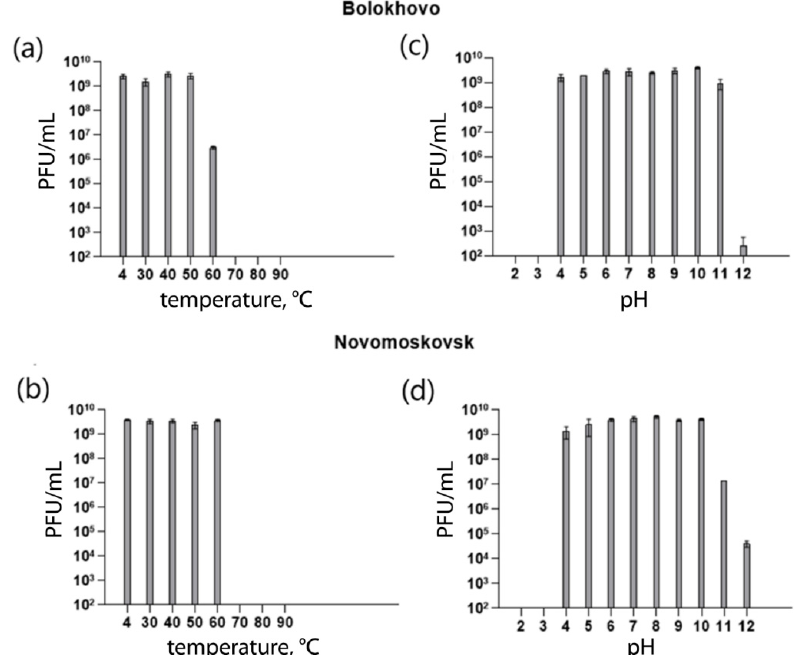
Figure 7. Thermal and pH stability of the Bolokhovo and Novomoskovsk phages. ( a , b ) Thermal stability diagrams; ( c , d ) pH stability diagrams. The results are expressed as the mean ± standard deviation for three replicates.